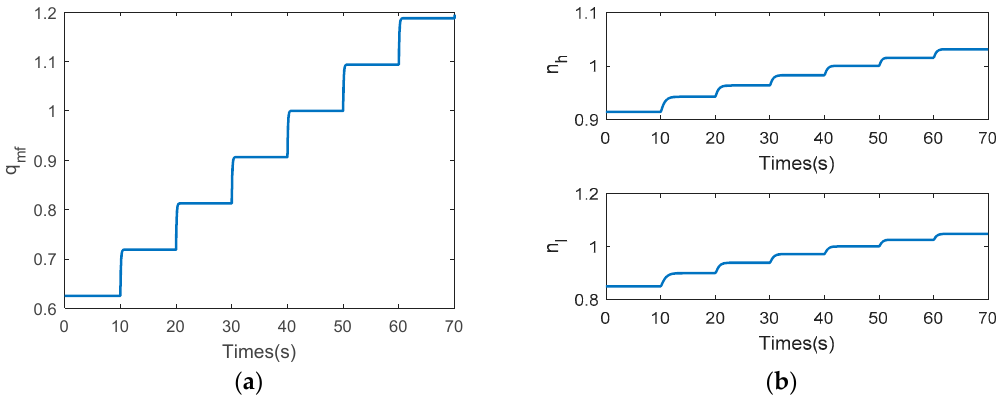
Figure 1. ( a ) Command signal of q mf ; ( b ) signals of n h and n l